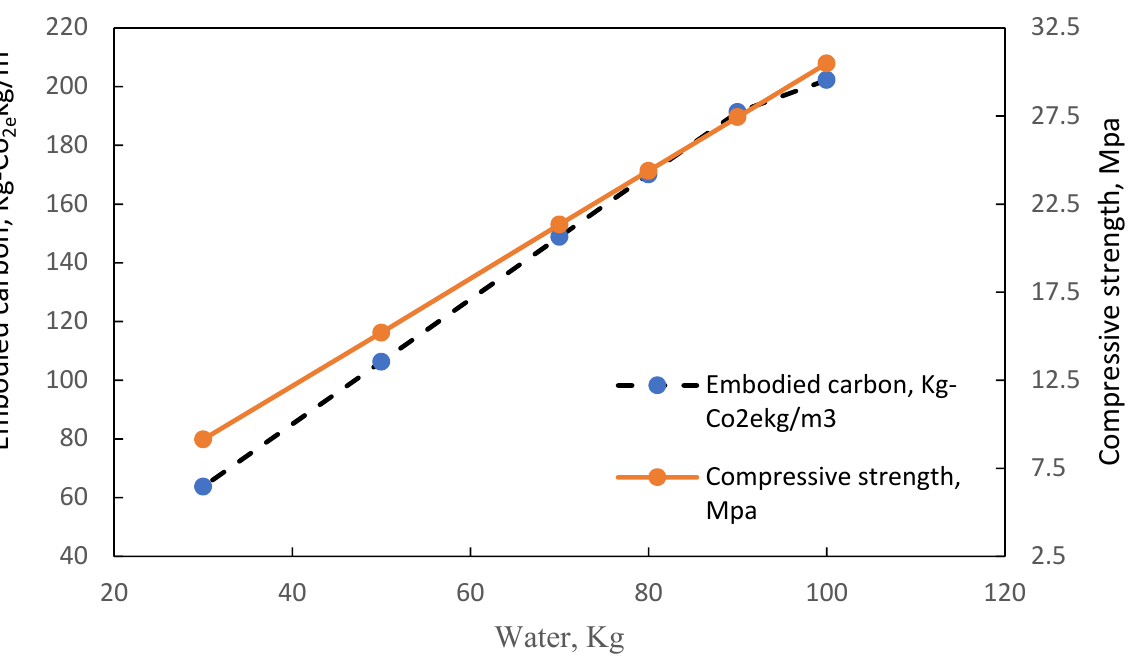
Figure 13. LCC at optimal water content of 80-100 litres per m 3 of concrete Batch B [32].